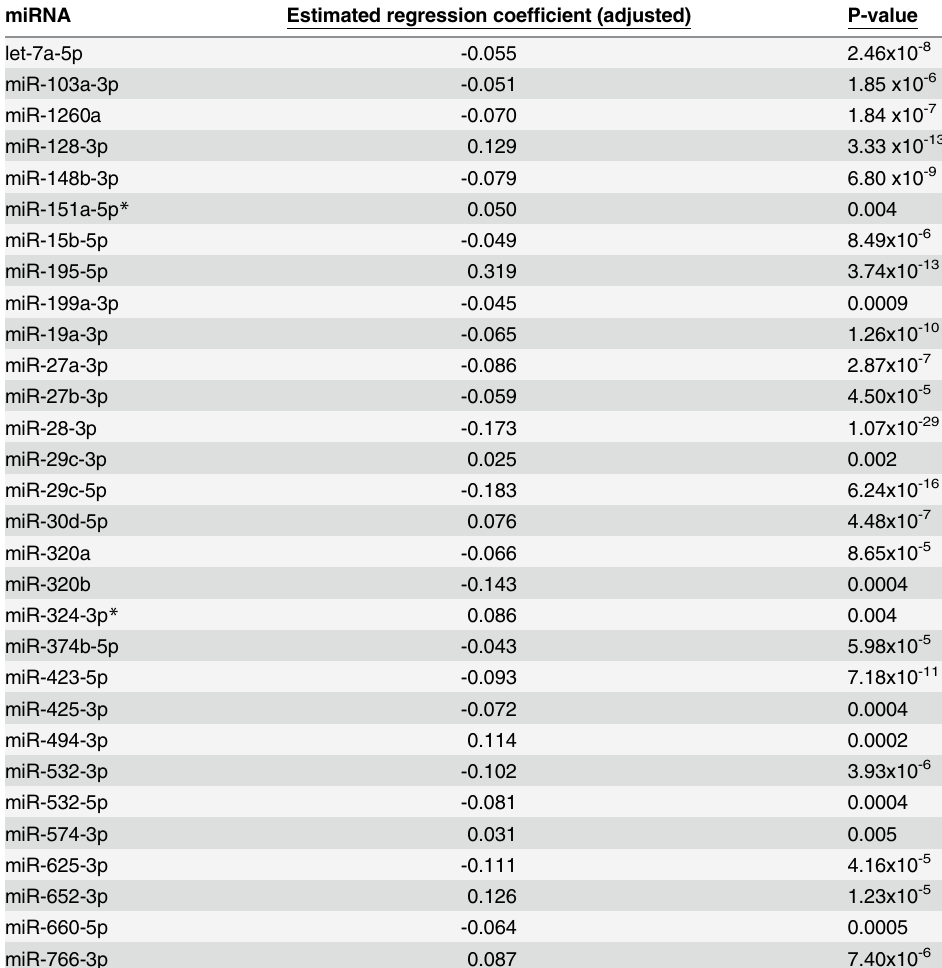
Table 2. Estimated regression coefficients from linear models of whole blood (independent) vs. plasma miRNAs (dependent variable in regression). Each model was adjusted for age, sex, and